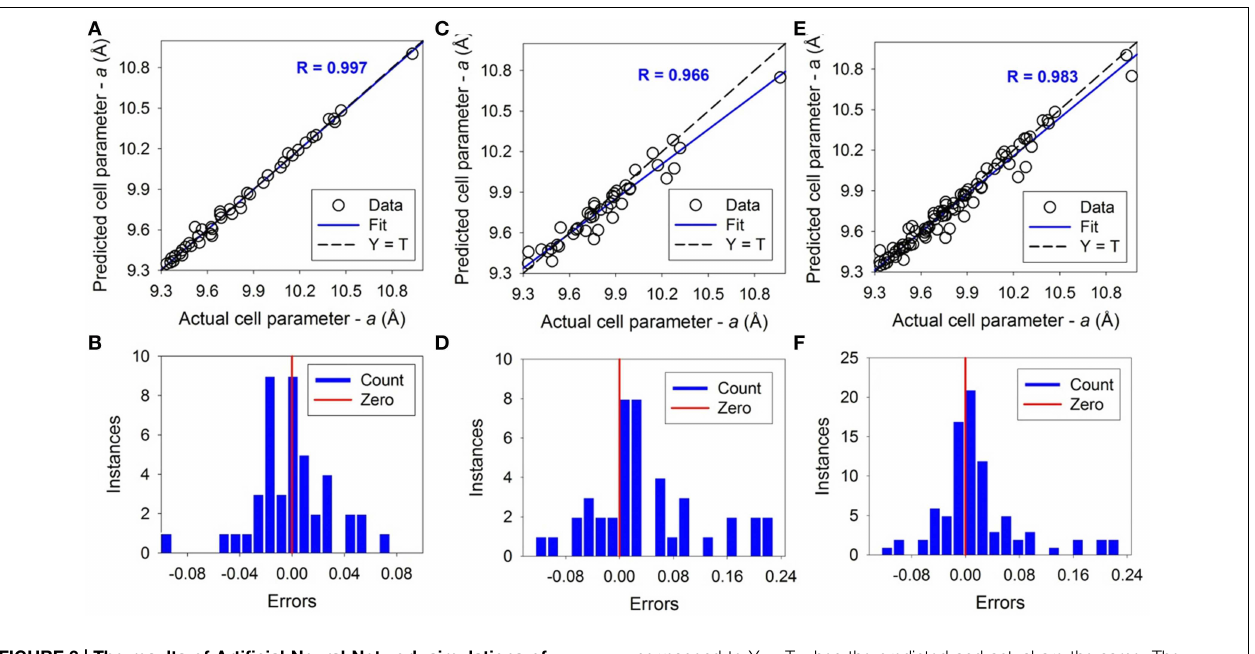
correspond to Y = T when the predicted and actual are the same. The solid lines correspond to linear fitting with a fitting coefficient of R. Open circles are experimental data. (A,B) are the result of training, (C,D) are of testing, and (E,F) are of the